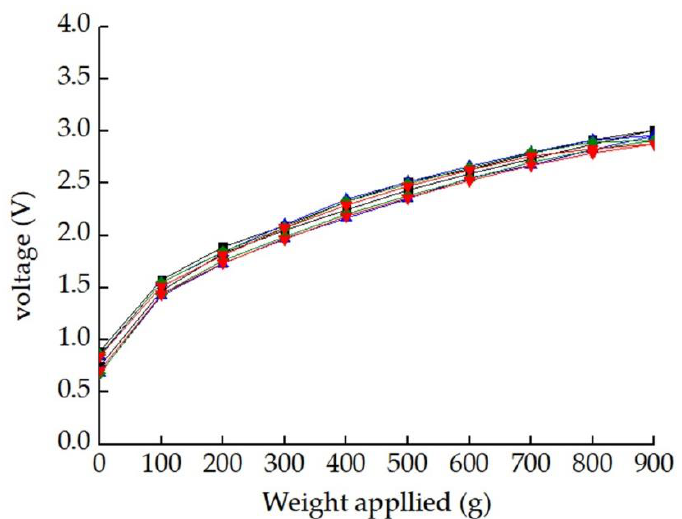
Figure 12. Relationship between the output voltage and the weight applied.